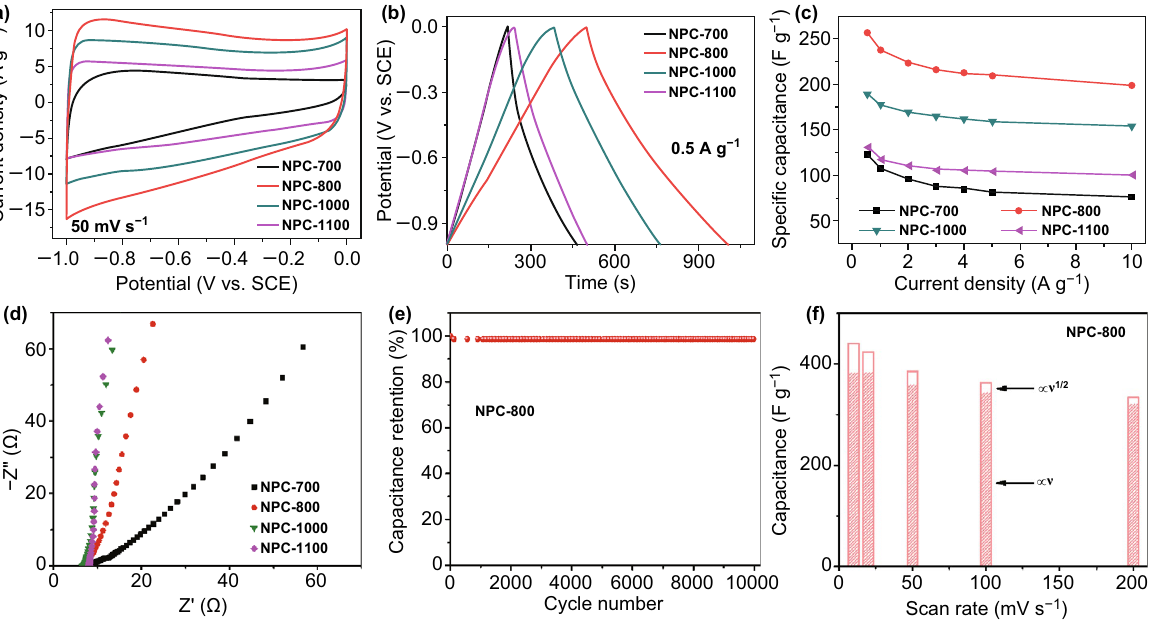
Fig. 6 a CV curves at 50 mV s −1 , b GCD curves at 0.5 A g −1 , c variations in the specific capacitances at different current densities and d Nyquist plots of NPC-700, NPC-800, NPC-1000, and NPC-1100 in a 6-M KOH electrolyte, e cycling performance of NPC-800 at a current den- sity of 10 A g −1 , f deconvolution of the charge contribution as a function of the scan